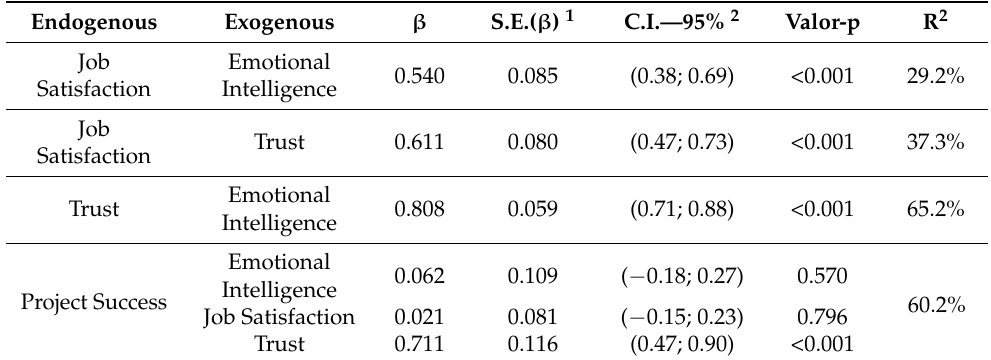
Table 3. Structural model Results.